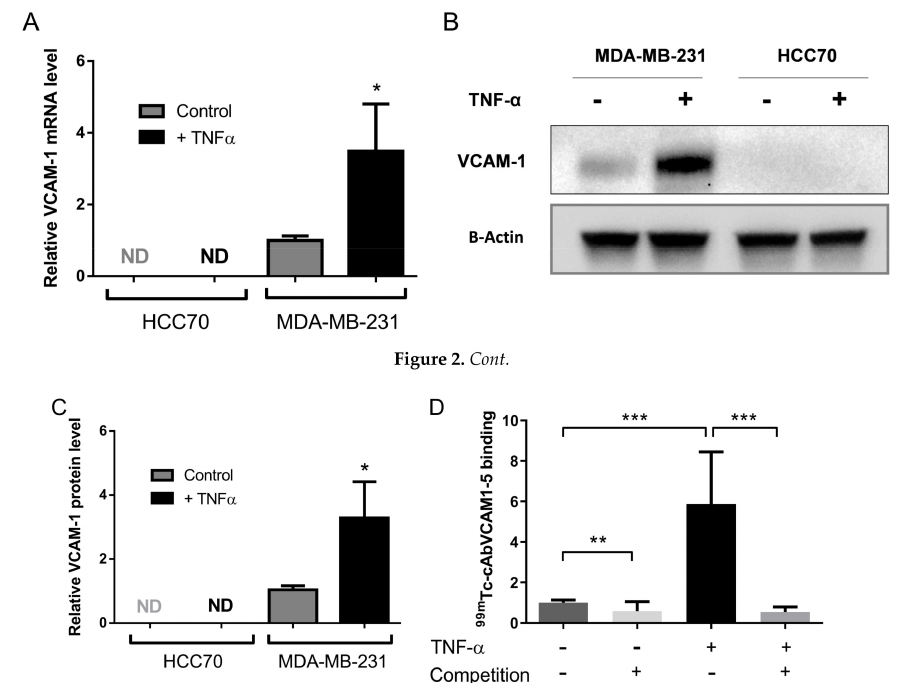
Figure 2. MDA-MB-231 cells overexpress VCAM-1 mRNA and protein upon TNF- α stimulation. MDA-MB-231 and HCC70 cells were treated or not for 18 h with TNF- α (50 ng / mL) and VCAM-1 expression was assessed by RT-qPCR ( A ) and WB ( B ). ( C ) Bands of WB were quantified using ImageJ software. ( D ) 99m Tc-AbVCAM1-5 binding was performed on MDA-MB-231 cells stimulated or not with TNF- α , in the presence or absence of a 100-fold excess of unlabeled cAbVCAM1-5. Unspecific binding was estimated by 99m Tc-AbVCAM1-5 incubation on HCC70 cells. Results are expressed in fold-change vs. untreated and unstimulated MDA-MB-231 N = 6 per condition. * p < 0.05; ** p < 0.01; *** p < 0.001; ND, not